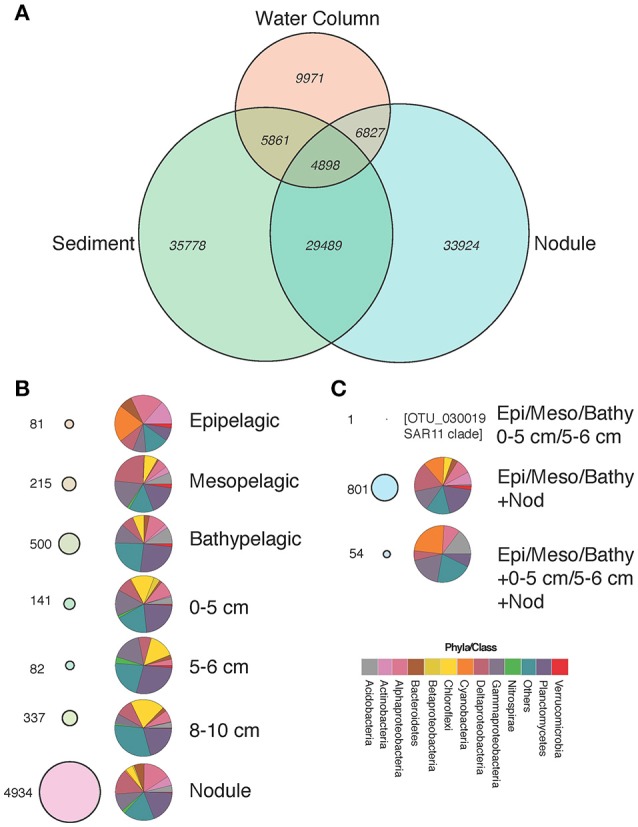
Venn diagram showing the distribution of OTUs and the number of shared OTUs between habitats (A), “Specialist” OTUs and their taxonomic affiliation (B), and “moderate generalist” and “generalist” OTUs and their taxonomic affiliation (C). All bubbles of “specialist,” “moderate generalists” and “generalists” in (A–C) are proportional to each other.